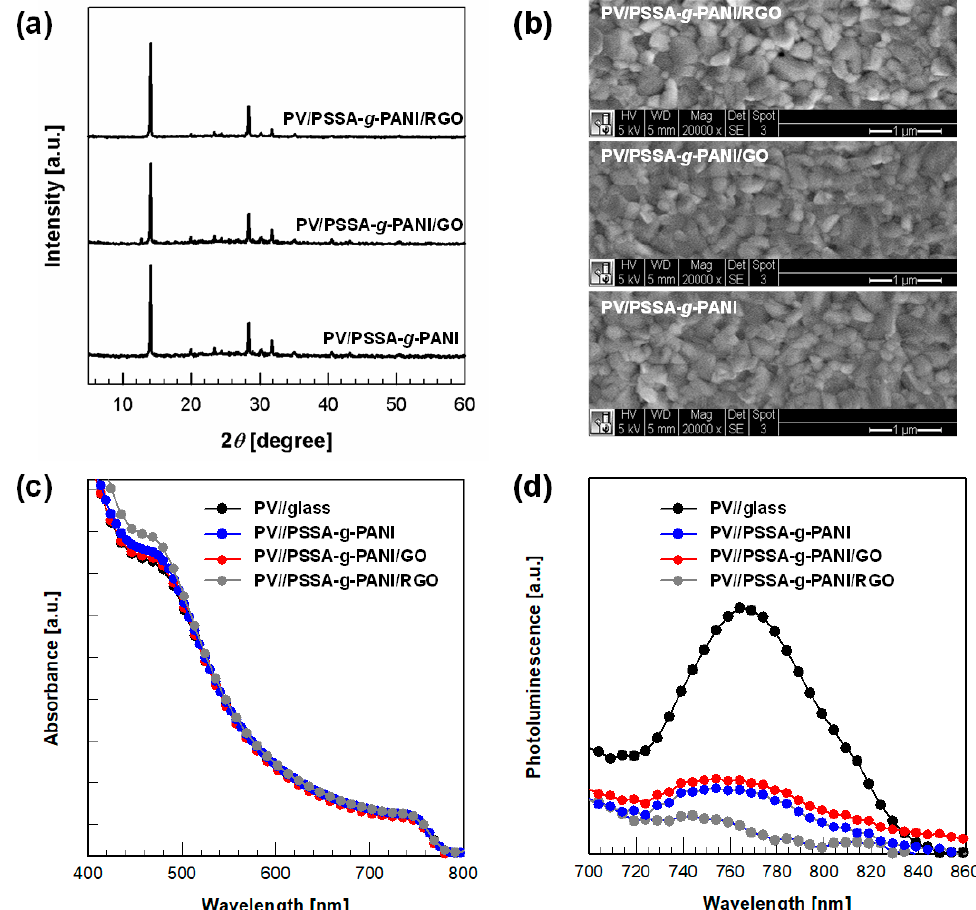
Figure 2. ( a ) XRD diffractograms, ( b ) FE-SEM images, ( c ) UV-Vis absorption spectra, and ( d ) steady state PL emission of the CH 3 NH 3 PbI 3 layer on the composite HTLs. Scale bar of FE-SEM image denotes 1000 nm.